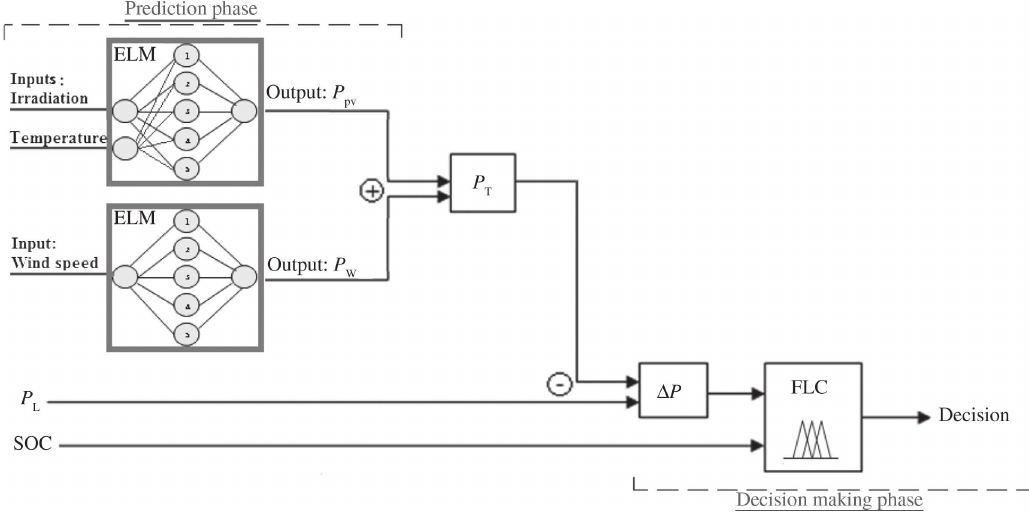
Figure 4: Proposed Energy Management